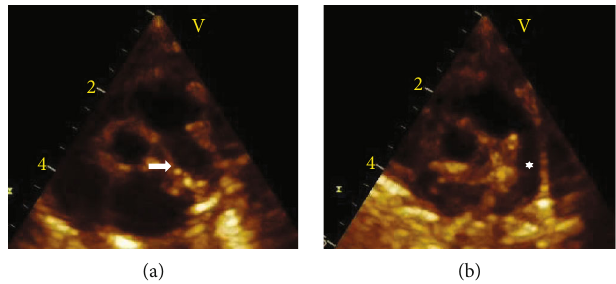
Figure 1: Cross-sectional echocardiogram (parasternal short axis view) showing (a) the LPA at its typical location (arrow) and absence of the RPA and (b) large left side PDA (asterisk). LPA: left pulmonary artery. RPA: right pulmonary artery.